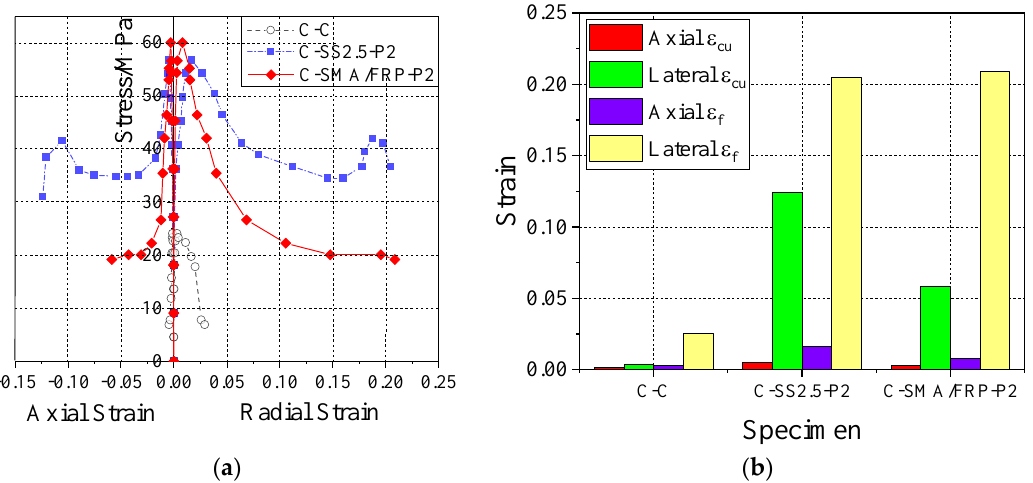
Figure 10. Axial and lateral stress–strain relation comparison of concrete cylinders with different reinforcement mode, which involves SMA and SMA/FRP: ( a ) Axial and radial stress-strain curves of concrete cylinders with different reinforcement mode, which involves SMA and SMA/FRP and ( b ) Comparison of axial and lateral peak strain and failure strain of concrete cylinders with different reinforcement mode, which involves SMA and SMA/FRP.